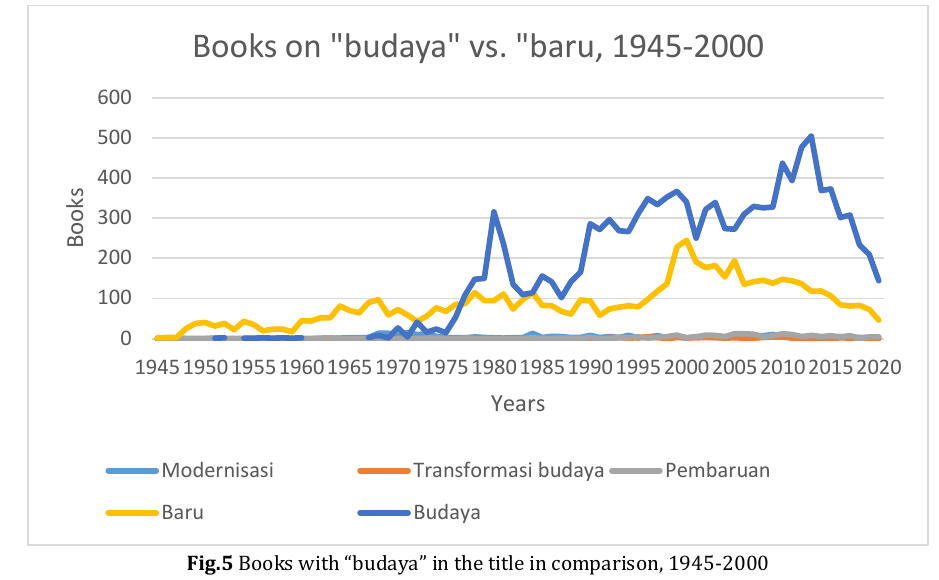
Fig.5 Books with “budaya” in the title in comparison, 1945